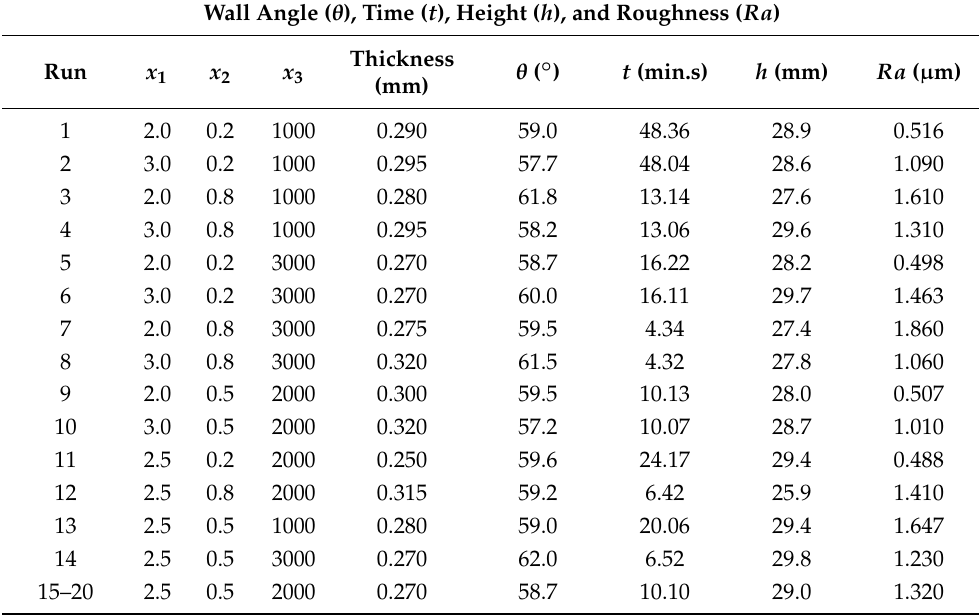
Table 4. CCF experimental design and experimental results using a 60° cone